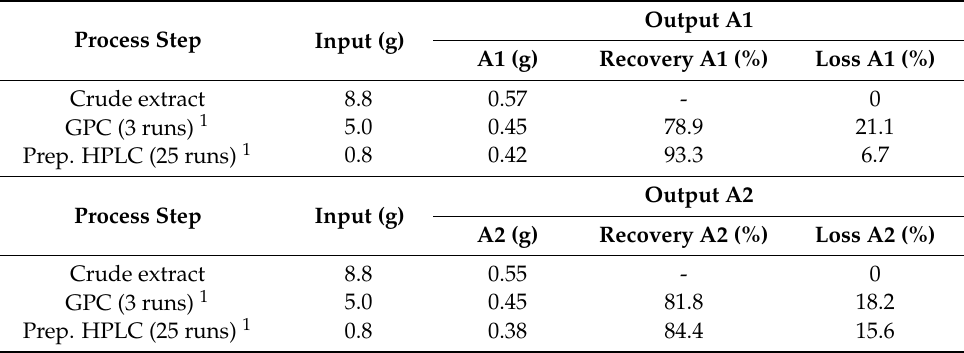
Table 1. Mass balance of the input and the output of major unit operations in the biomass downstream processing.